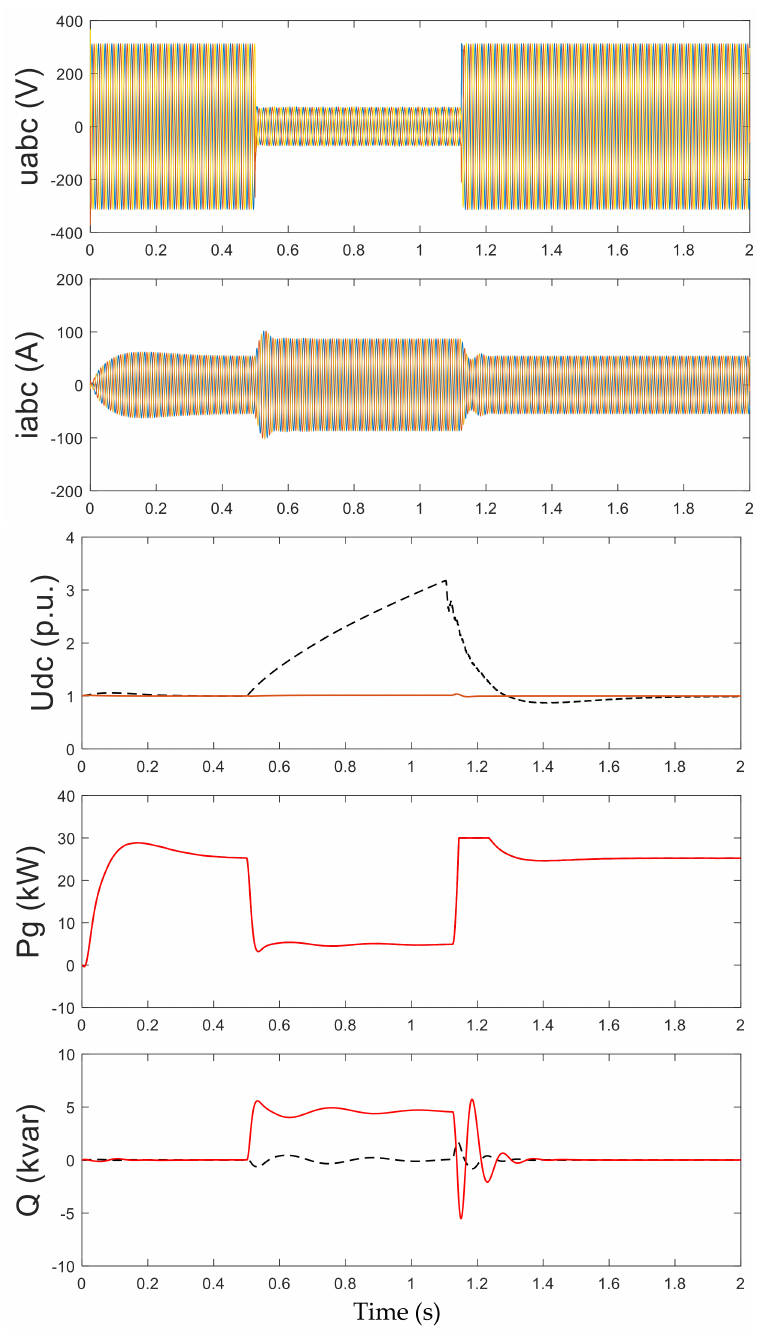
Figure 16. The simulation results comparison between the conventional control and the overspeed- while-storing